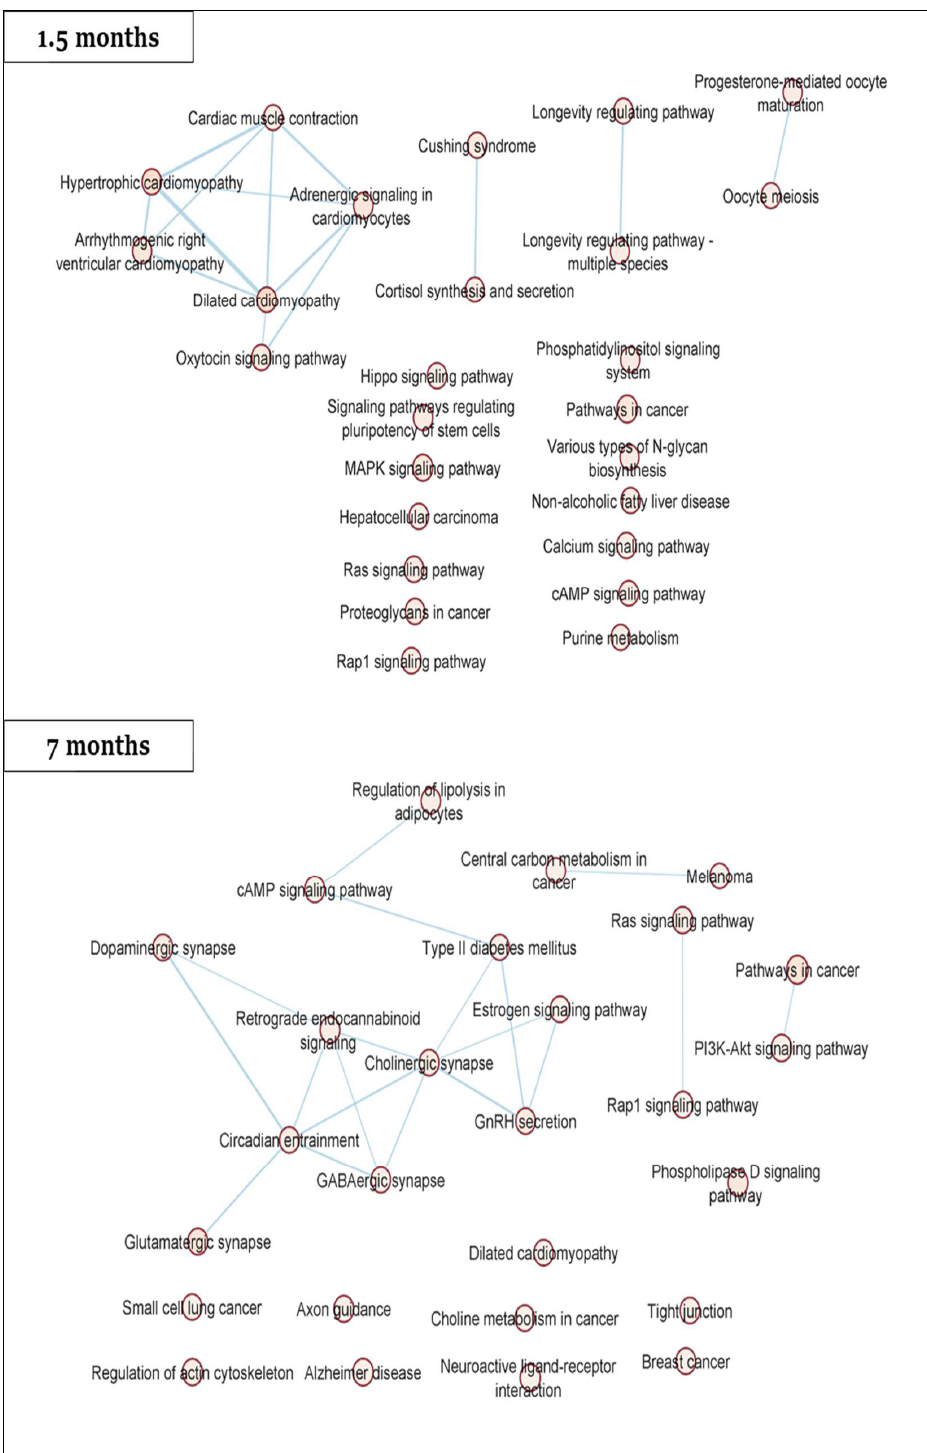
Figure 3. Pathway analysis of significant DMRs ( p -value < 0.05). Statistically significant KEGG pathways ( p -value < 0.05, Q-value < 0.25) were visualized by STRING-db and Cytoscape, respectively.